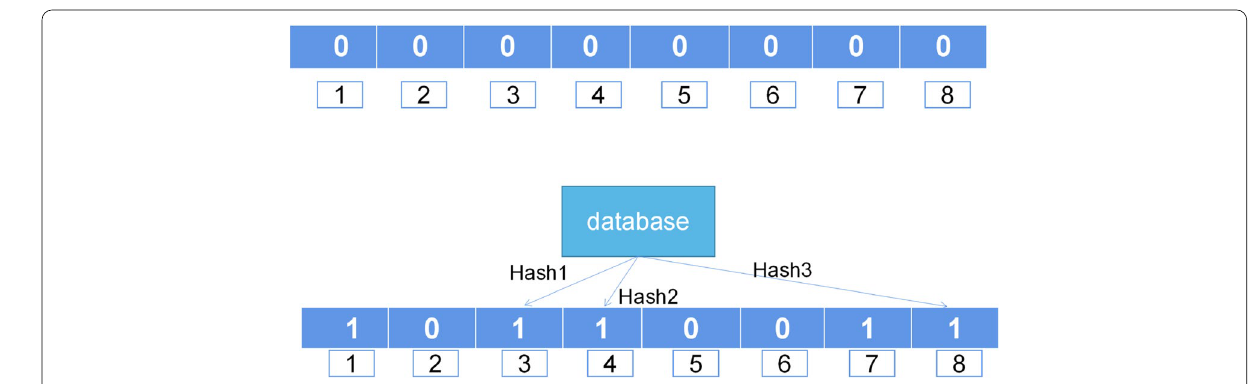
Fig. 1 Structure of bloom